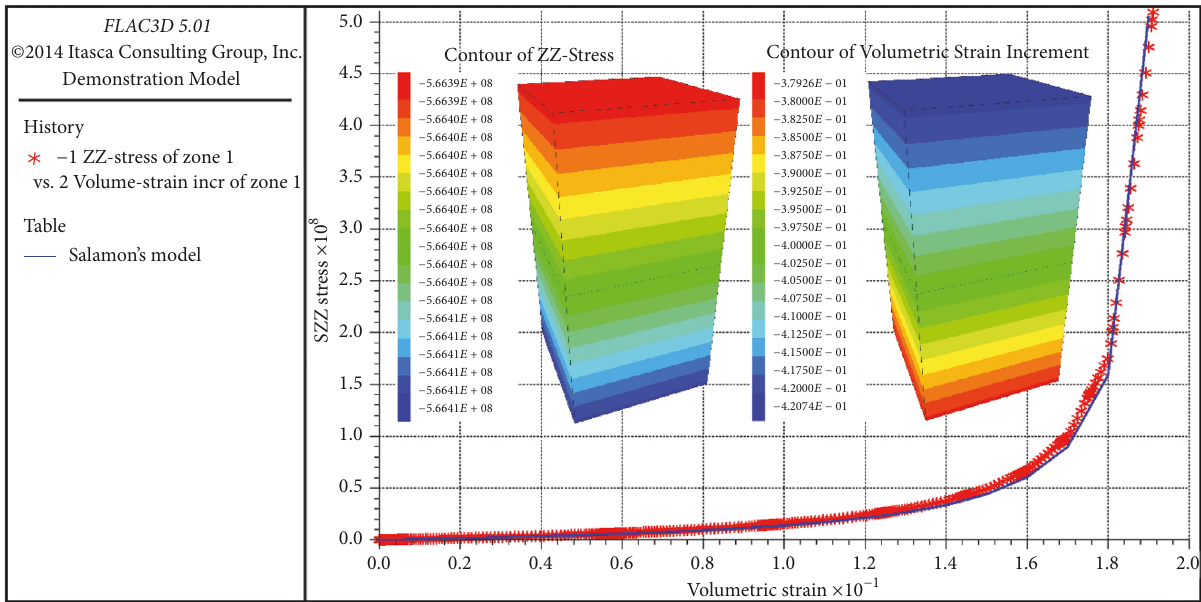
Figure 13: The volumetric strain, vertical stress contours, and stress–strain matching curves.